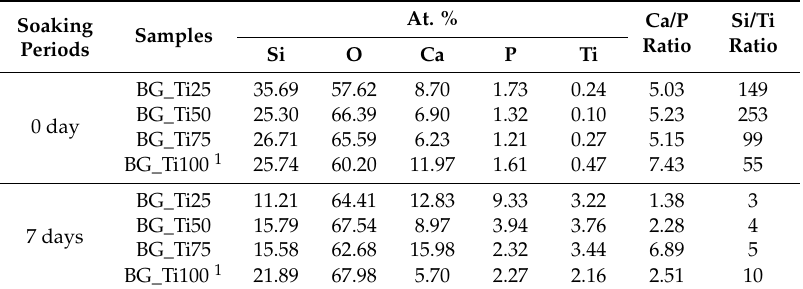
Figure 1. The microstructures of bioceramics composed of silica and titanium oxide with various concentrations of titanium oxide soaking in simulated body fluid (SBF) for ( a ) 0 days and ( b ) 7 days. Table 1. The atomic ratio of bioceramics composed of silica and titanium oxide with various concentrations of titanium oxide after soaking in SBF for 7